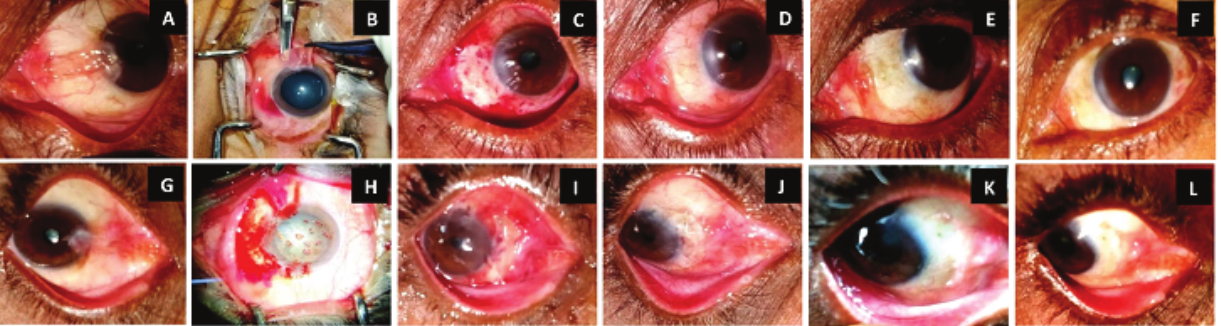
Figure 1. Serial clinical photographs of two patients of primary pterygium: (Patient 1 [A ∼ F]; Patient 2 [G ∼ L]): preoperative, intraoperative, and postoperative. Pterygium excision with CAG with fibrin glue (A–F) and pterygium excision with mini-SLET (G– L). (A) A case of primary nasal pterygium (left eye[LE]) before pterygium excision with CAG. (B) Dissection of pterygium. (C) POD 1. (D) POD 30 graft well taken. (E & F) Postoperative months 6 and 9, respectively: restoration of near normal anatomy without any recurrence. (G) A case of primary nasal pterygium (Right eye [RE]) before pterygium excision with mini-SLET. (H) Intraoperative photograph showing dissected pterygium with eight limbal pieces. (I) POD 1. (J) POD 30: well-settled graft. (K & L) Postoperative months 6 and 9, respectively: restoration of near normal anatomy without any signs of